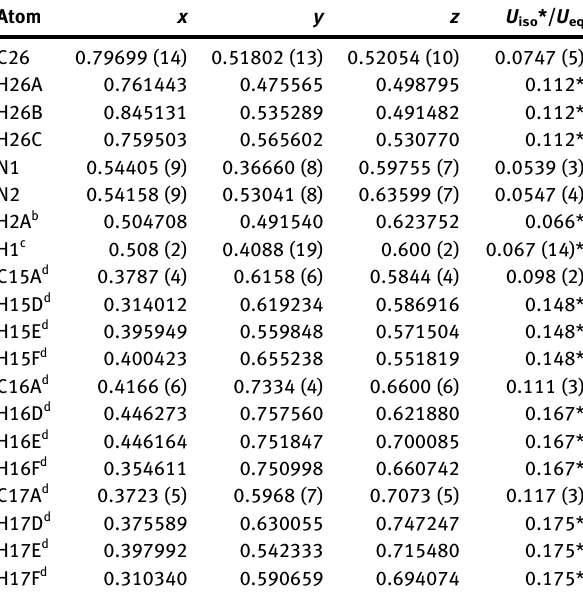
column chromatography, yielding a yellow powder. Crystals